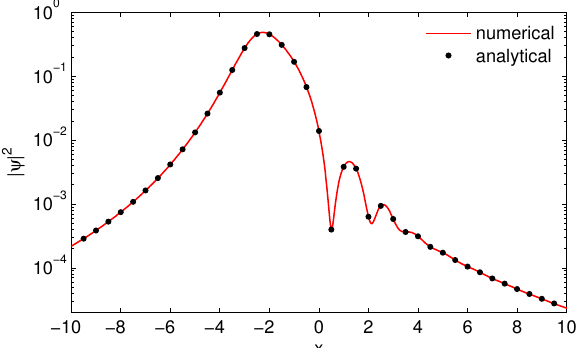
Figure 7. Comparison between the analytical solution Equation ( 25 ) and the matrix approach Equation (62) for the case of a liner potential with β =